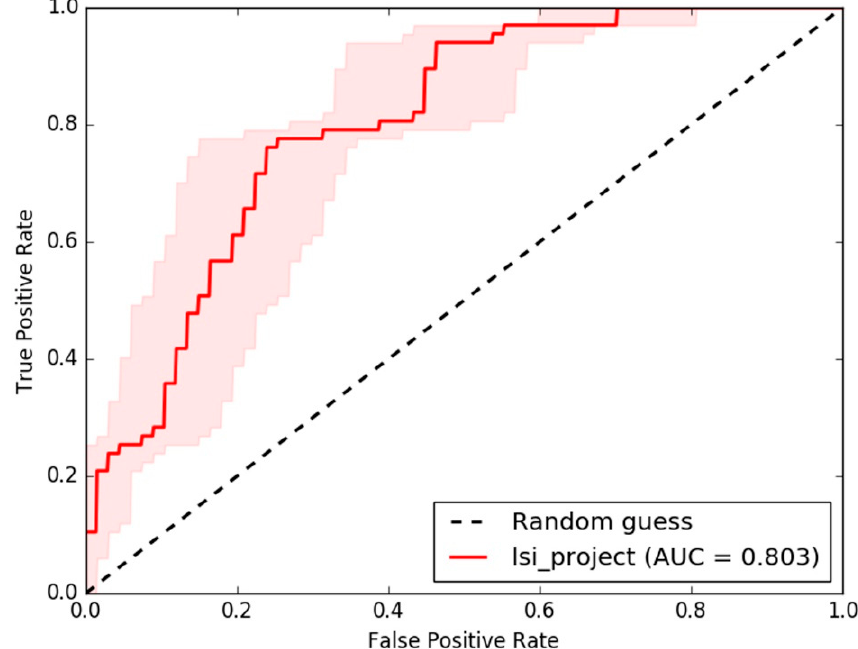
Figure 11. ROC graph and AUC for the landslide susceptibility model applied for Cephalonia.